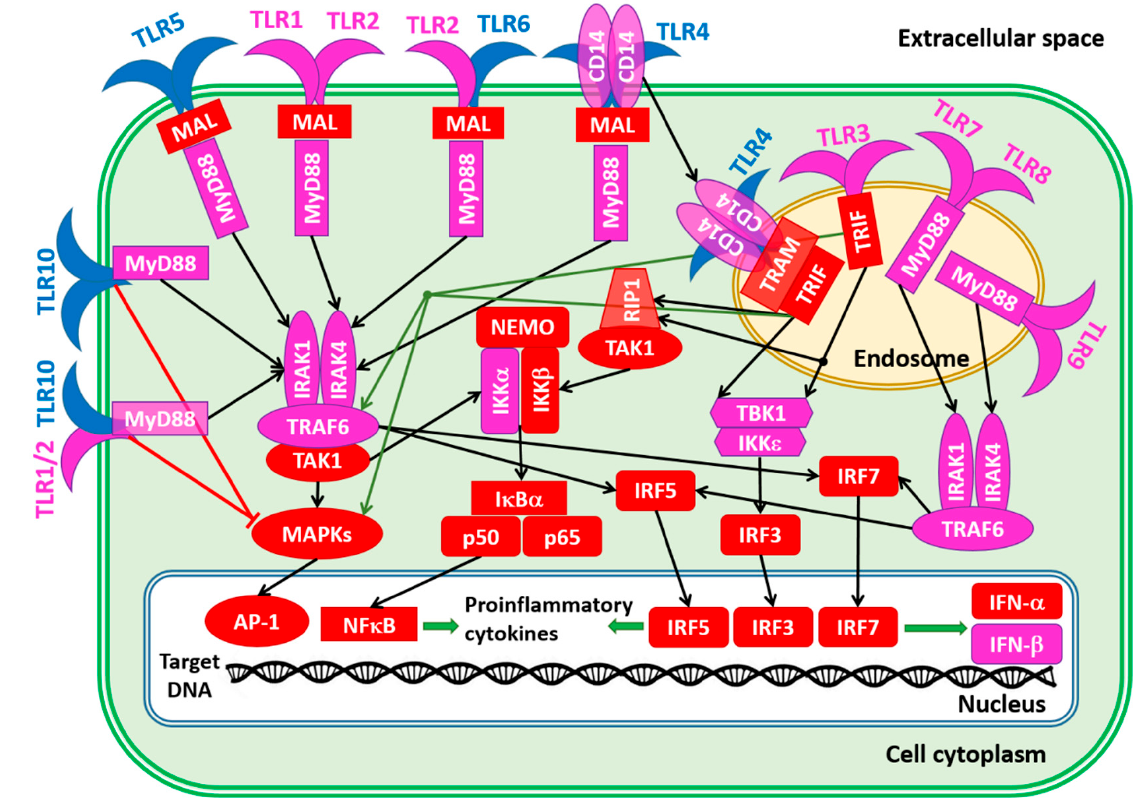
Figure 8. A schematic representation of the TLRs and related signaling networks. MyD88 binding to the activated TLRs directly or via MAL initiates the MyD88- dependent downstream signaling pathways [166,167]. Here, MyD88 interacts and activates the IL-1 receptor-associated kinases IRAK1 (PPIDR = 52.67%) or IRAK4 (PPIDR = 33.48%). Activated IRAKs form a complex with TRAF6 (tumor necrosis factor (TNF) receptor- associated family 6, PPIDR = 23.37%). This leads to the activation of TAK1 (transfor- mation growth factor- β (TGF- β )-activated kinase, PPIDR = 57.10%), which activates the IKK α /IKK β /IKK γ complex (inhibitors of nuclear factor- κ B (NF- κ B) kinase α , β , and γ , PPIDR = 24.56%, 35.45%, and 98.57%, respectively) and MAPKs (mitogen-activated protein kinases 1–15, whose PPIDR values range from 13.89% in MAPK14 to 63.24% in MAPK7). Note that MAPK8, MAPK9, and MAPK10 are also known as c-Jun N-terminal ki- nases 1, 2, and 3, JNK1, JNK2, and JNK3 with PPIDs of 27.63%, 27.36%, and